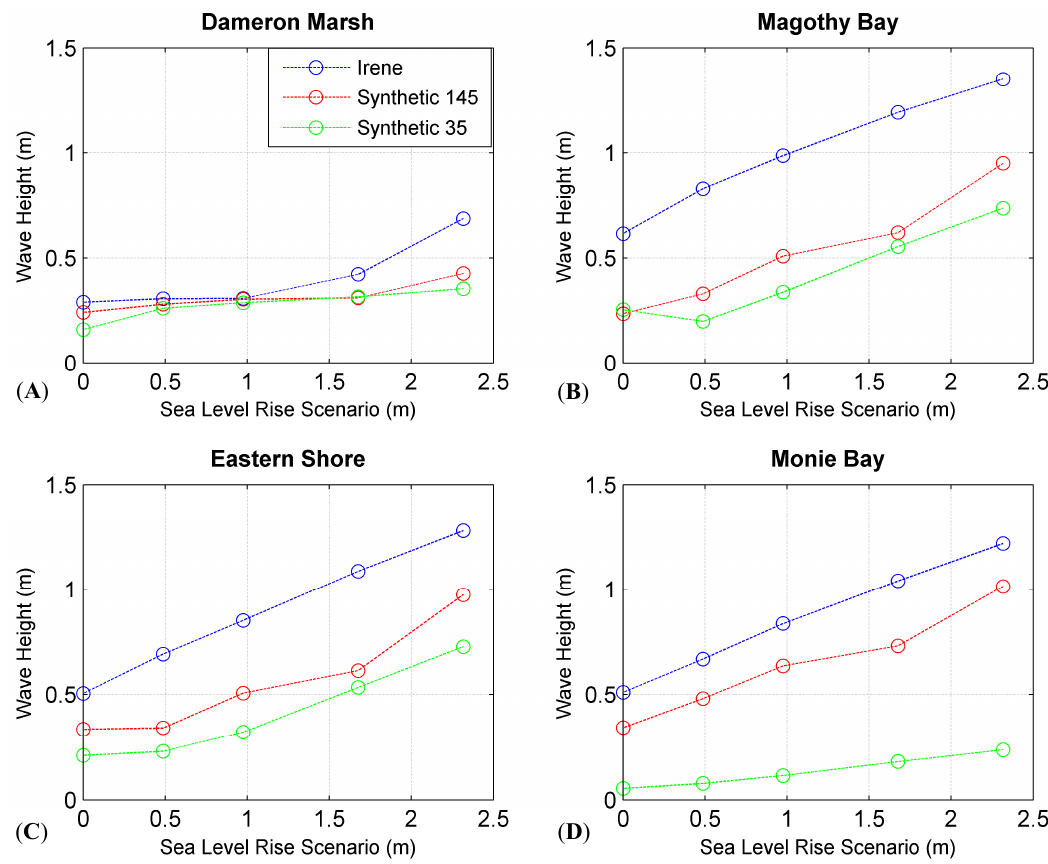
Figure 7. Maximum wave heights at each preserve areas for current condition and different SLR scenarios. The top panel shows the simulated maximum wave heights in ( A ) Dameron Marsh and ( B ) Magothy Bay. In the bottom panel results are shown for ( C ) Eastern Shore and ( D ) Monie Bay Preserve Area.